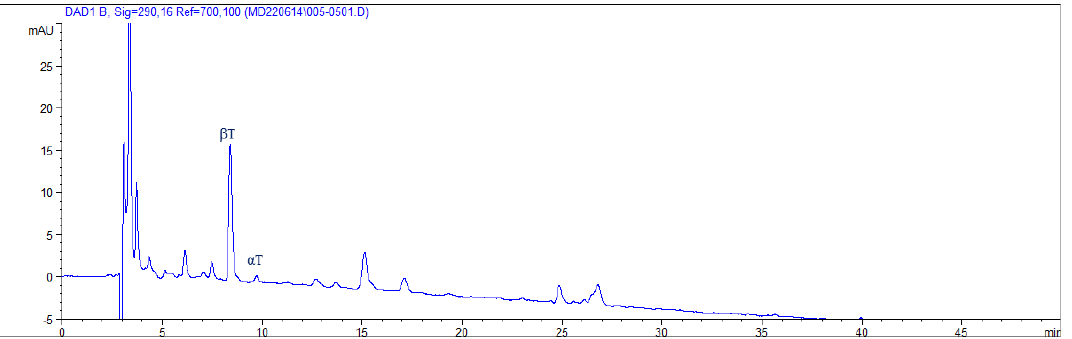
Figure A5. Representative chromatogram of tocochromanols identified on the basis of RT and ab- sorption spectra in the extracts of Chifaa and lentil 6002/ILWL118/1-1. βT, αT: β - Tocopherol and α - Tocopherol, respectively.